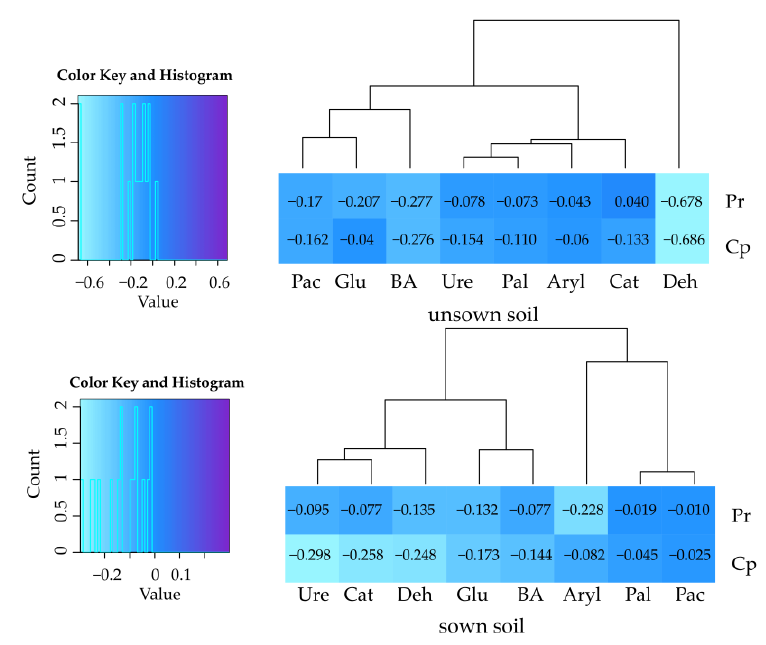
Figure 1. Index of the influence of insecticides (IF in ) on soil enzyme activity. Deh—dehydrogenases;